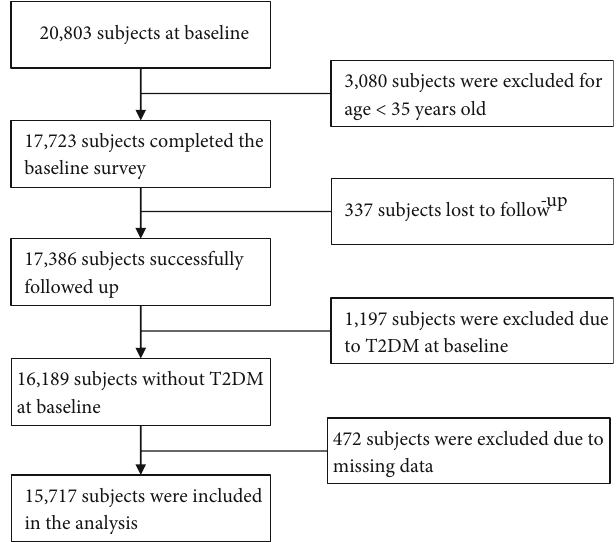
Figure 1: Flow chart of the study sample showing inclusion and exclusion of